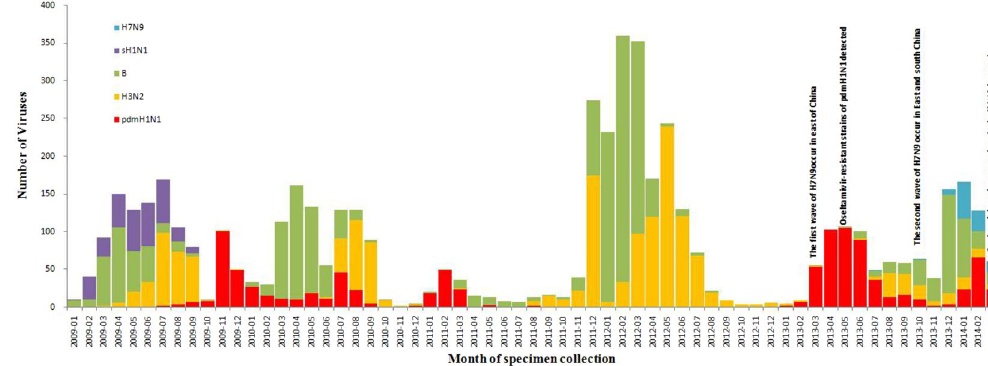
Figure 1. The number of influenza virus isolates by subtype in Guangdong, China from January 2009 to March 2014. The specimens of nasopharyngeal swabs were collected from patients through the influenza surveillance network of Centers for Disease Control and Prevention of Guangdong. All specimens during 2009 to 2014 were isolated for influenza viruses with MDCK and further subtype. Five color columns represented for the number of five subtype isolates which distributed in different month, respectively. The blue column stands for the number of H7N9 strains, the purple column stands for the number of seasonal A(H1N1) strains, the green column stands for the number of seasonal B strains, the yellow column stands for the number of seasonal A(H3N2) strains, the red column stands for the number of A(H1N1) pdm09